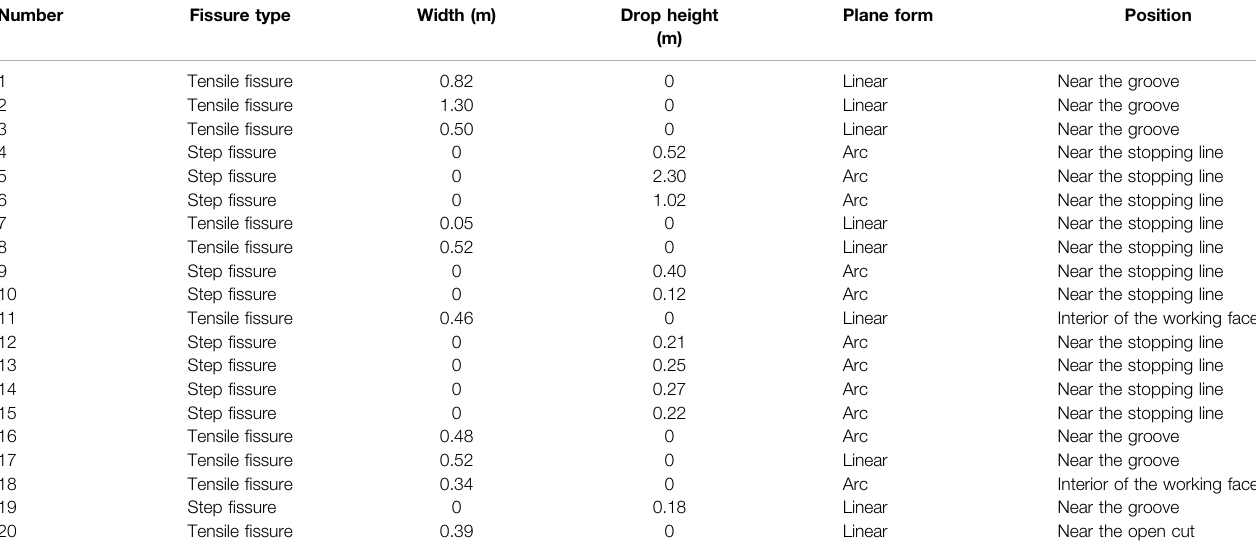
TABLE 6 | Survey of ground fi